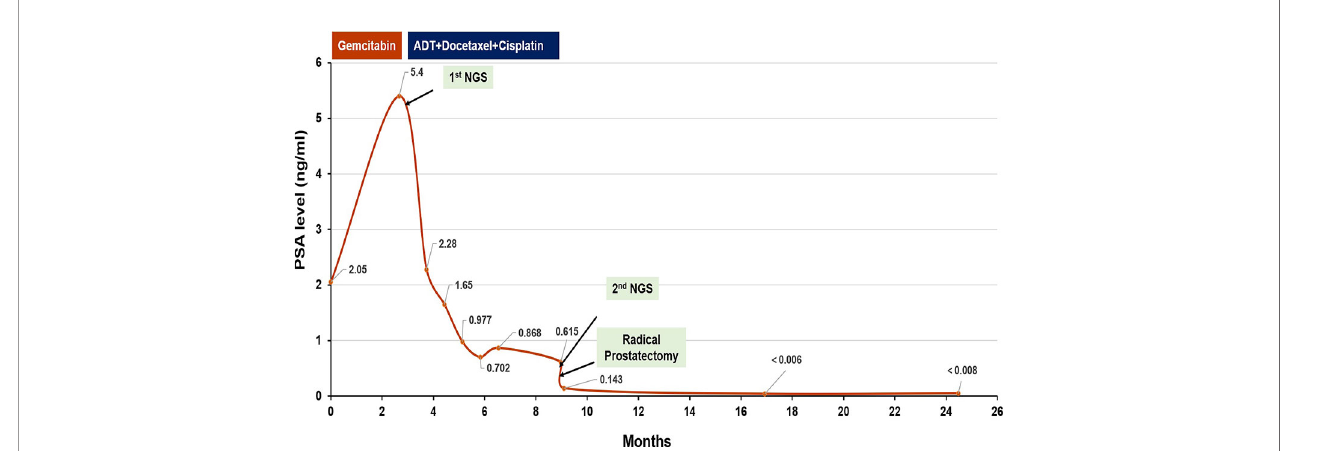
FIGURE 3 | The clinical treatment course and prostate-speci fi c antigen